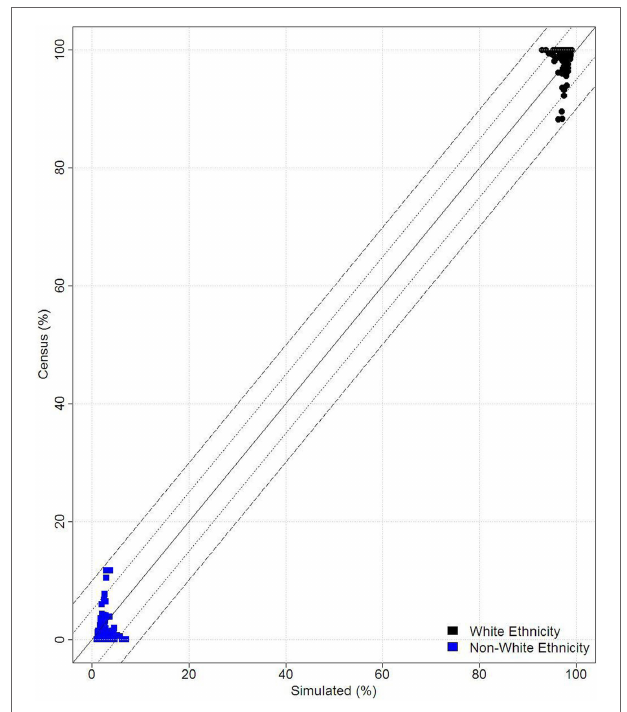
FigUre 8 | Validation results